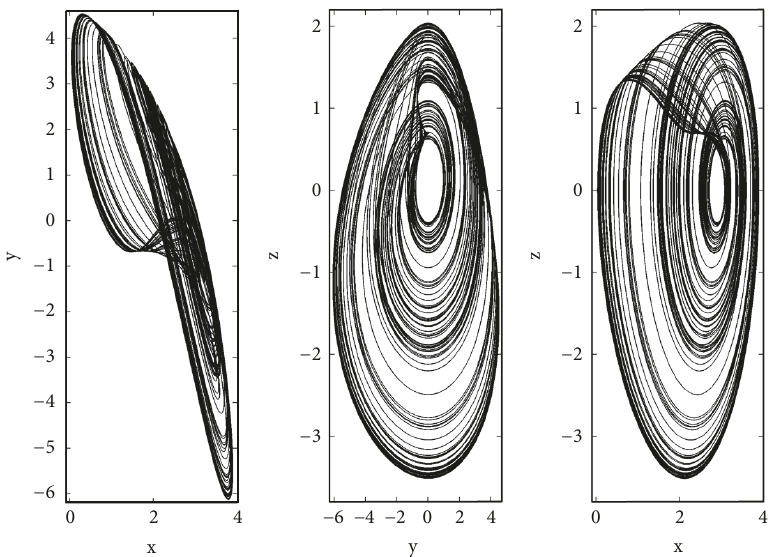
Figure 4: 2D phase portrait of system (1a), (1b), and (1c) for 𝑎 = 3.3 and 𝑏 = 3 . The initial conditions are (x(0), y(0), z(0)) = (1, 0,